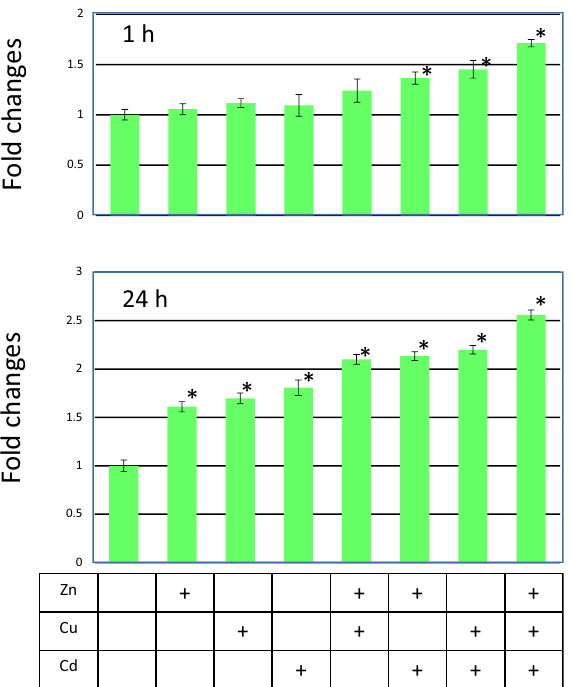
Figure 6. GFP expression by multiple heavy metals exposure. Seven day old D. magna MetalloG was exposed to 0.9 µM of Zn 2+ , 20 nM of Cu 2+ , or 110 nM of Cd 2+ , and a combination of these metals. After 1 h and 24 h exposure, GFP expression was quantified, These values were divided by that of control (0 µg/L) expression level and fold changes were calculated. Metal ions used for the exposure are indicated in the boxes (+presence of ion indicated on the left column (Y-axis indicates fold changes. * p < 0.05 (t-test) Measured concentrations are indicated in Supplementary Table